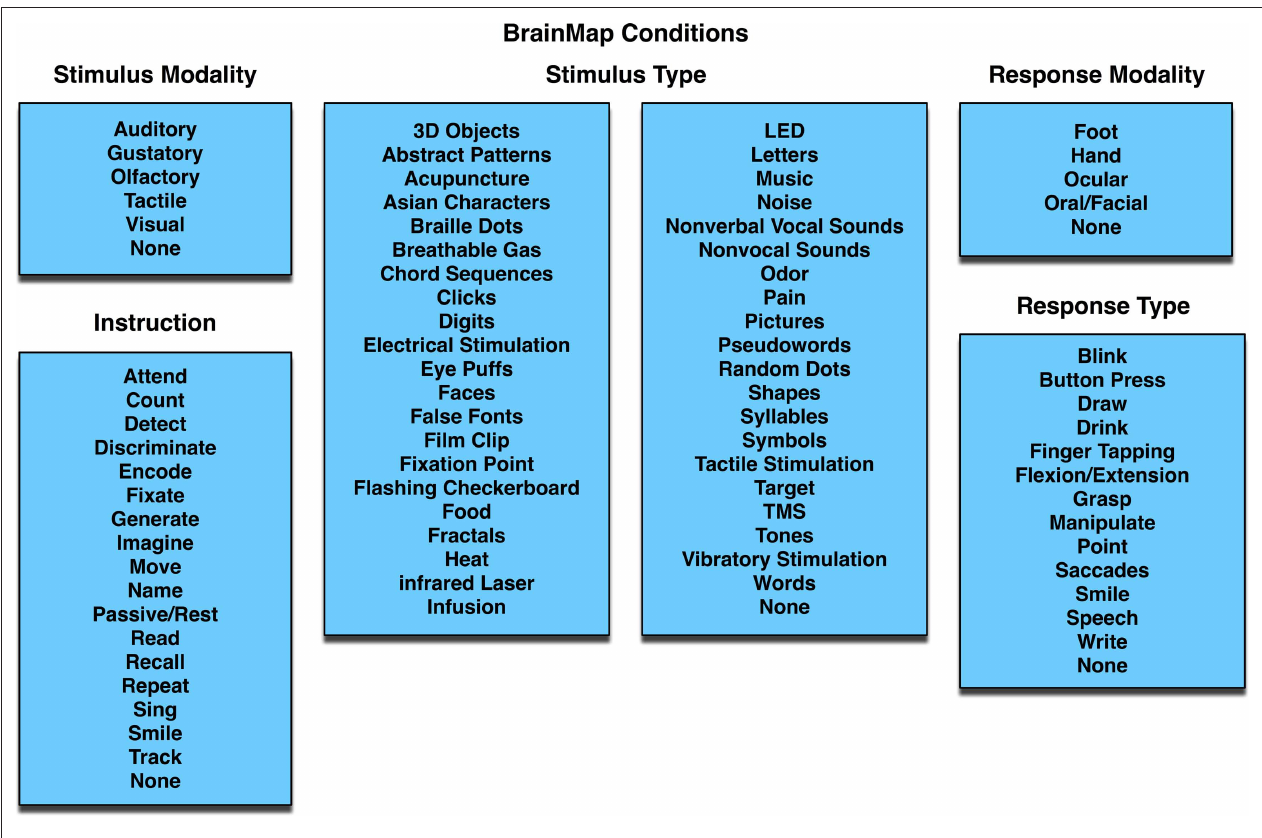
response (modality and type). The values in the BrainMap metadata scheme are standardized to as few options as possible, so as to group similar studies. The blue background represents that this fi eld lies at the Paper